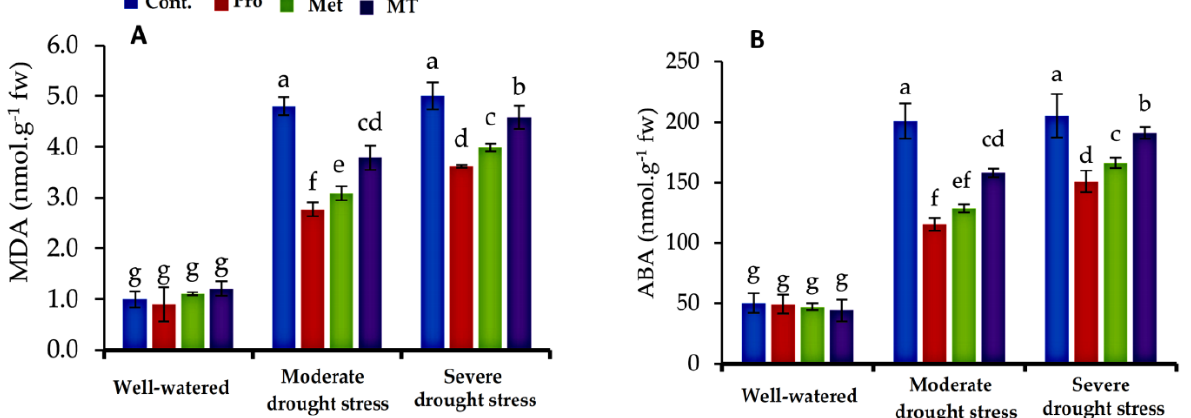
Figure 2. Impact of interaction between treatments (proline, methionine, and melatonin) and water levels on malondialdehyde (MDA, ( A )) and abscisic acid (ABA, ( B )) of cauliflower plants grown under different levels of irrigation water. Bars indicates standard error (SE) of the means (n = 6). Different letters indicate significant differences between the treatments at according to Tukey’s multiple range test ( p ≤